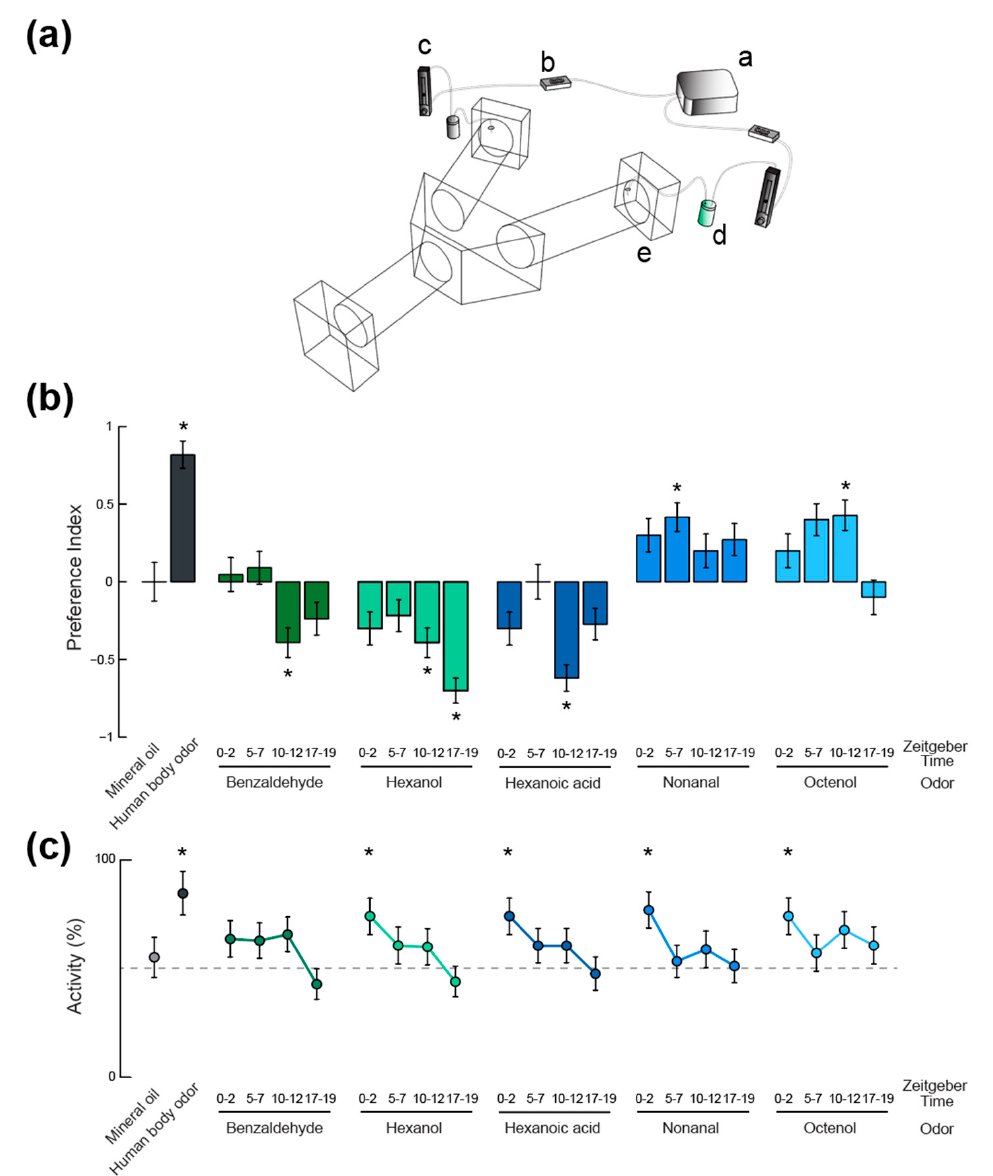
Figure 3. Time-of-day and odorant-specific olfactory activation and behavioral responses of Ae. aegypti adult female mosquitoes. ( a ) Schematic representation of the Y-maze olfactometer used in behavioral assays. ( i ) air pump; ( ii ) charcoal filter; ( iii ) flowmeter; ( iv ) scintillation vial containing either the odorant stimulus or the solvent only; ( v ) delivery of the odor laden air into the choice arms of the olfactometer. Mosquitoes are released into the entrance arm and fly upwind where they are forced to make a decision between the two choice arms, each delivering a different odor stimulus. ( b ) Mosquito odor preference represented as a preference index. Asterisks denote behavioral responses that were significantly different from chance (Binomial Exact test, p < 0.05). ( c ) Proportion of activity (i.e., proportion of mosquitoes making an active choice between the two choice arms of the olfactometer) under different olfactory contexts and at four different times of day. Asterisks denote proportions that were significantly different from activity levels in absence of odor (55%; Binomial Exact test, p < 0.05). In ( b , c ), error bars represent the standard error to the